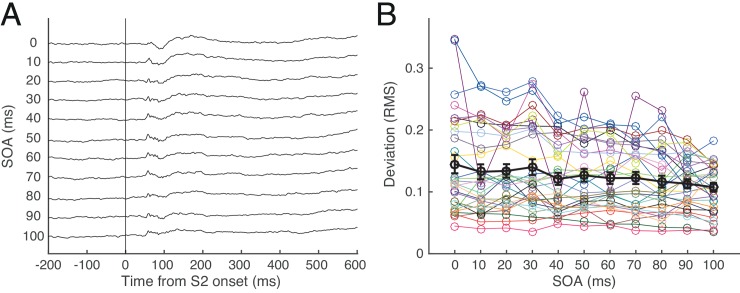
Deviation of LFP from linear sum in the representative cell of Fig 3.
A. Shown are LFP traces in an arbitrary unit for each SOA condition derived by the mean LFP traces observed during S1-S2 sequence stimulation minus the SOA-adjusted linear sum of S1-evoked LFP and S2-evoked LFP. B. Deviation of LFP in RMS power. Each colored symbol represents the mean deviation across SOA conditions for each of 30 cells shown in Fig 5. Black symbols represent their mean values with 1SEs.